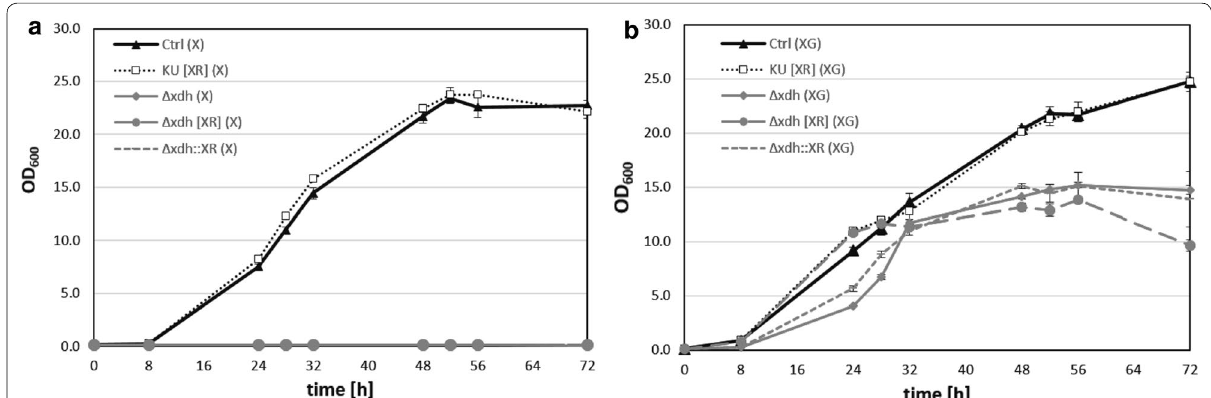
Fig. 4 Growth evaluation of M. guilliermondii strains with xylose only or xylose Ctrl (KU [EV]) (filled triangles) with mutant strains KU [XR] (open square), xdhΔ (filled diamond), xdhΔ [XR] (filled circle) and xdh∆::XR (dashed lines) in YNB media with a 20 g l − 1 xylose (X) or b 20 g l − 1 xylose and 20 g l − 1 glucose (XG); Displayed are mean values